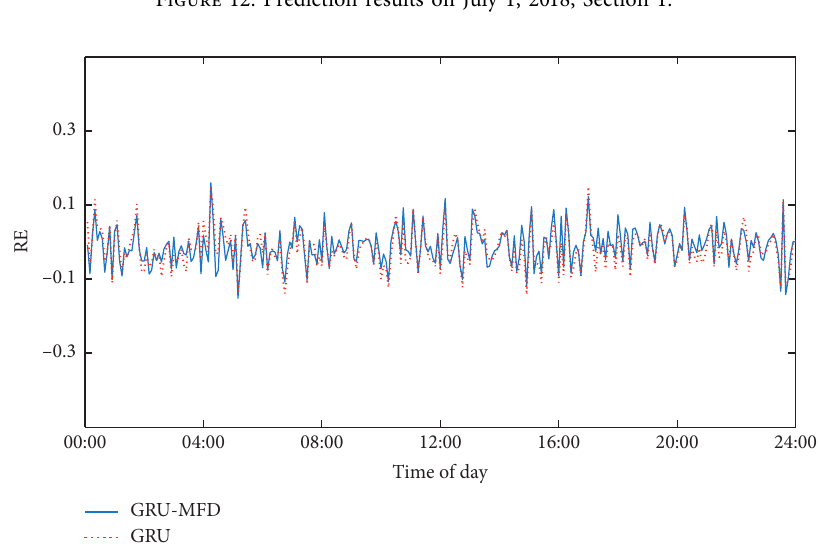
Figure 12: Prediction results on July 1, 2018, Section 1.